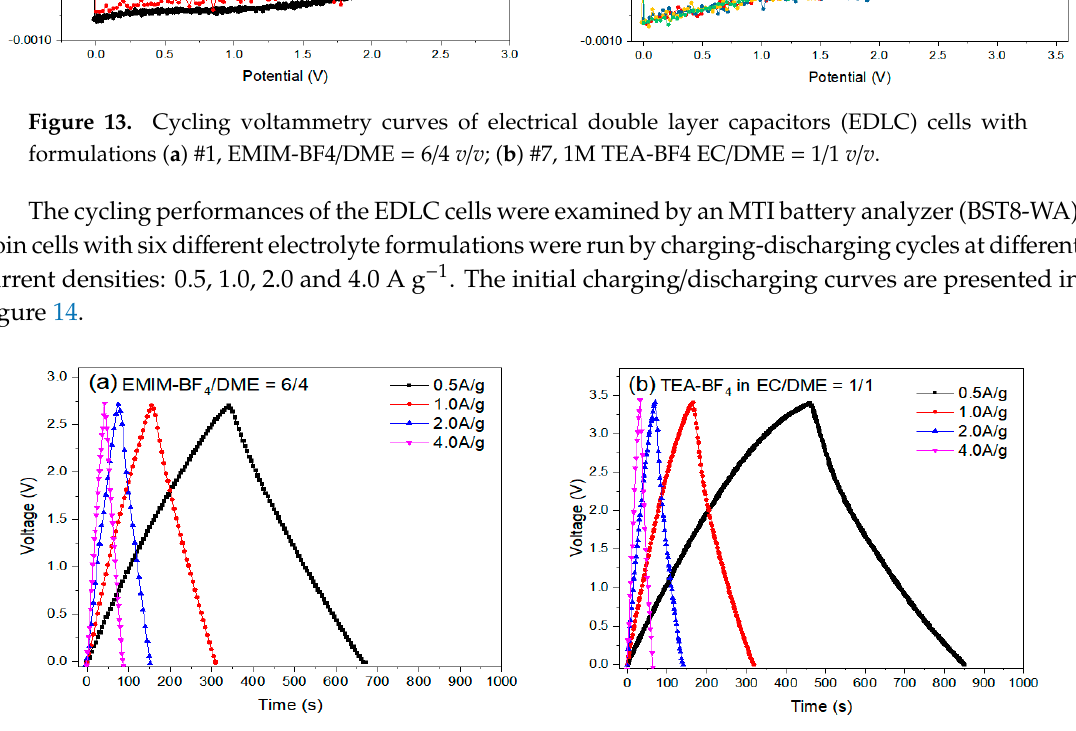
Figure 14. The initial charging-discharging curves at different current rates of EDLCs with electrolytes ( a ) #1, EMIM-BF4/DME = 6/4 v / v , ( b ) #7, 1M TEA-BF4 in EC/DME = 1/1 v / v .